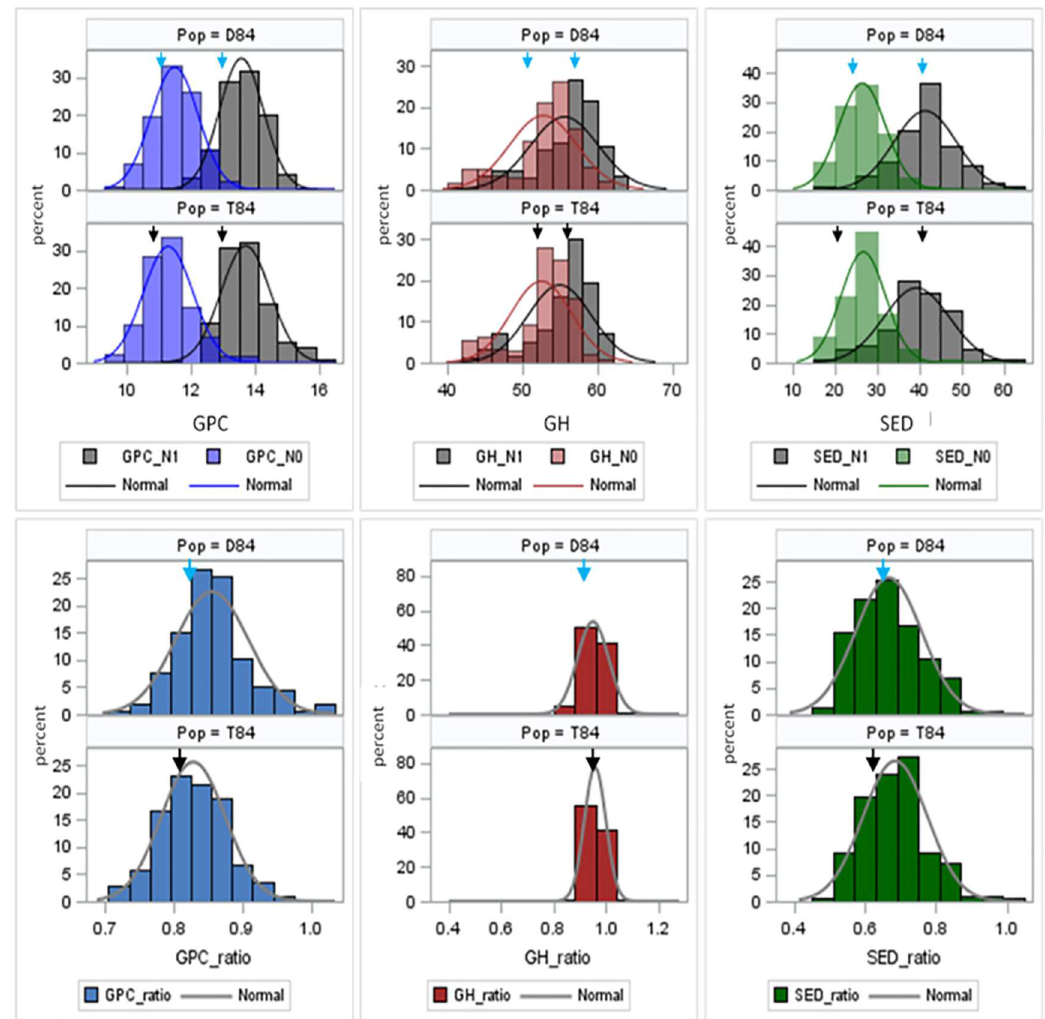
Fig 2. Frequency distribution of mean trait performance for GPC, GH, SED and the respectiveratios, separated per family (D84 and T84) and color-coded for N0 and N1 treatments. The overlappingareas are colored in dark blue, dark red and dark green, respectively.Vertical arrows indicatemean values of controls Devon (blue) and Triso (black), respectively.